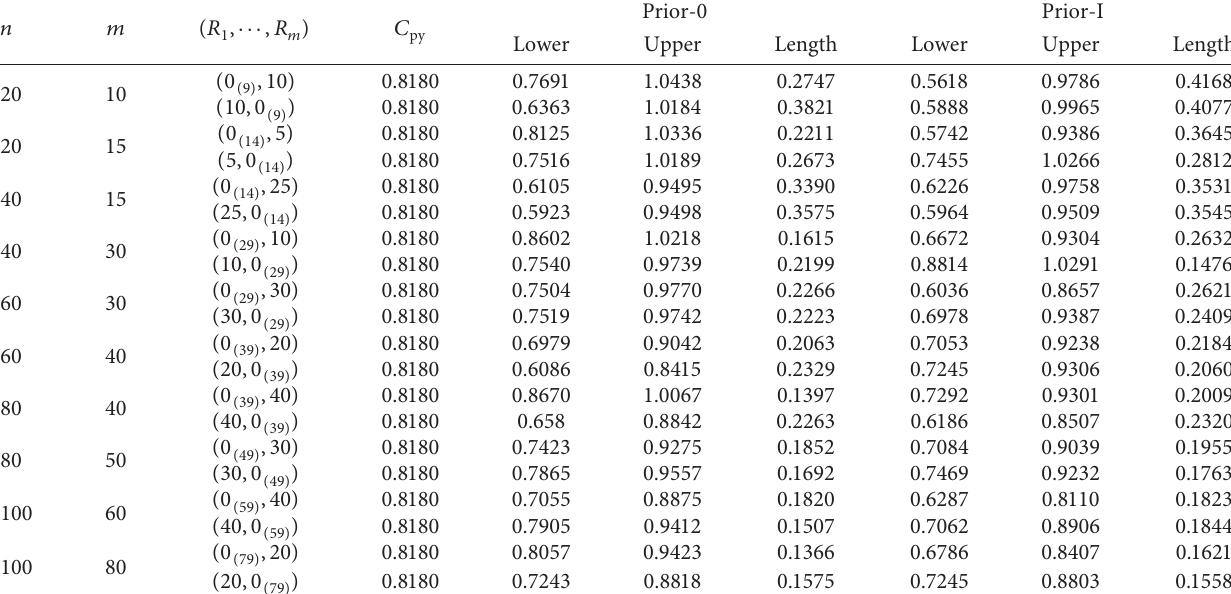
Table 10: True value of C and its 95% CRIs when α � 4 . 40 , θ � 5 . 79 , and c � 0 . py